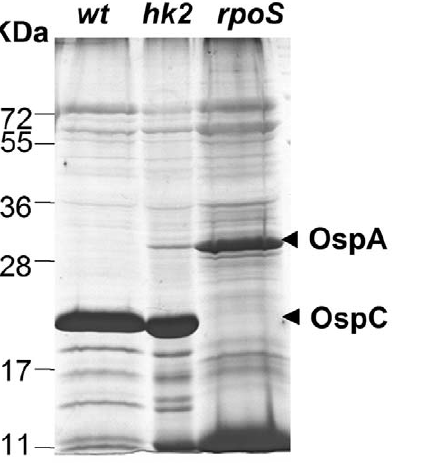
Figure 2. hk2 mutant spirochetes cultivated in DMCs are capable of activating the Rrp2-RpoN-RpoS pathway. Wild-type ( wt ), hk2 mutant ( hk2 ), or rpoS mutant ( rpoS ) spirochetes were cultivated in DMCs, after which whole cell lysates were separated by SDS-PAGE and visualized with silver stain. The bands corresponding to OspA and OspC are indicated by arrowheads on the right. Molecular mass markers in kilodaltons are shown on the left. doi:10.1371/journal.ppat.1001104.g002 PLoS Pathogens |